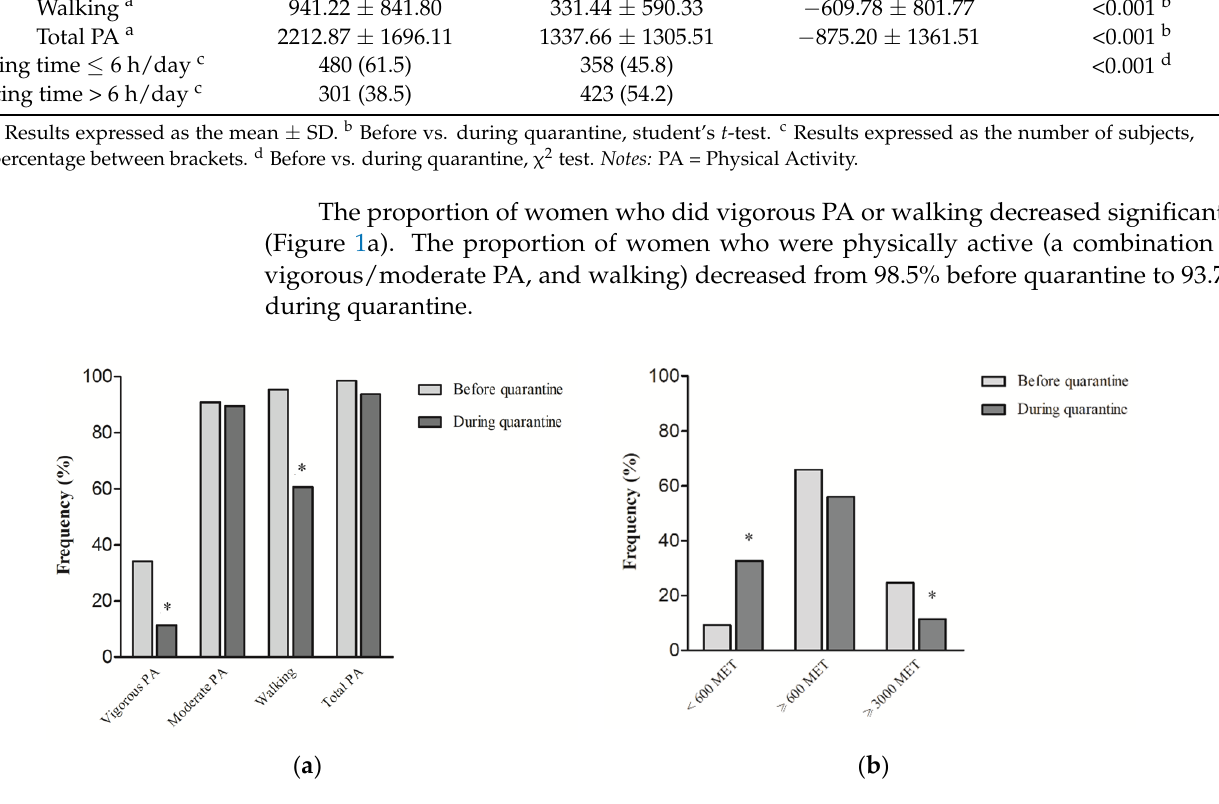
Figure 1. ( a ) Proportion of total and domain-specific physical activity of women before and during COVID-19 home confinement; ( b ) Proportion of low active (MET < 600), moderate active (MET ≥ 600), and high active (MET ≥ 3000) women before and during COVID-19 home confinement. * Before vs. during quarantine, χ2 test, p < 0.05; Notes : IPAQ score is expressed as MET-min/week; PA = Physical Activity.